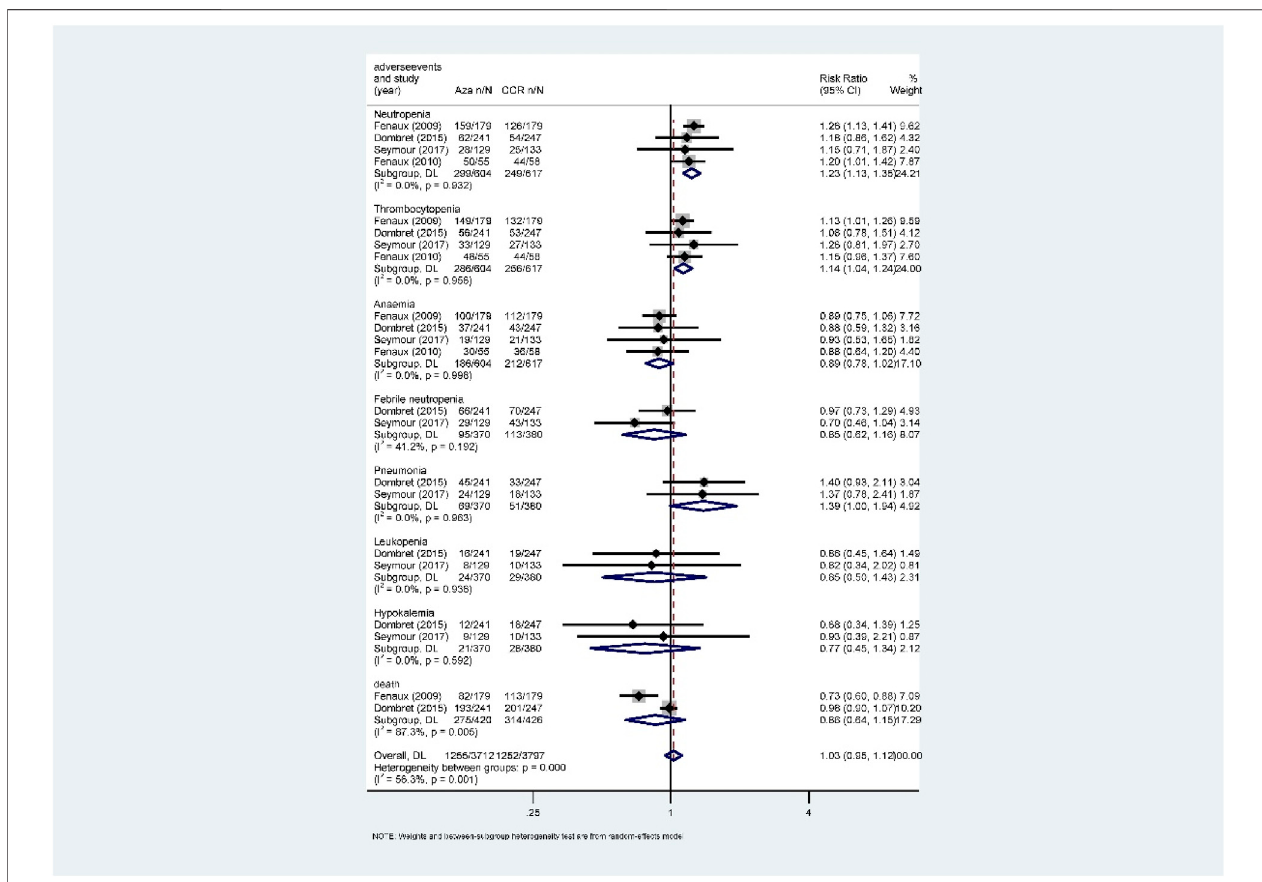
FIGURE 7 | Forest plot of grade 3/4 adverse events of azacitidine vs. conventional care regimens (direct evidence-RR).